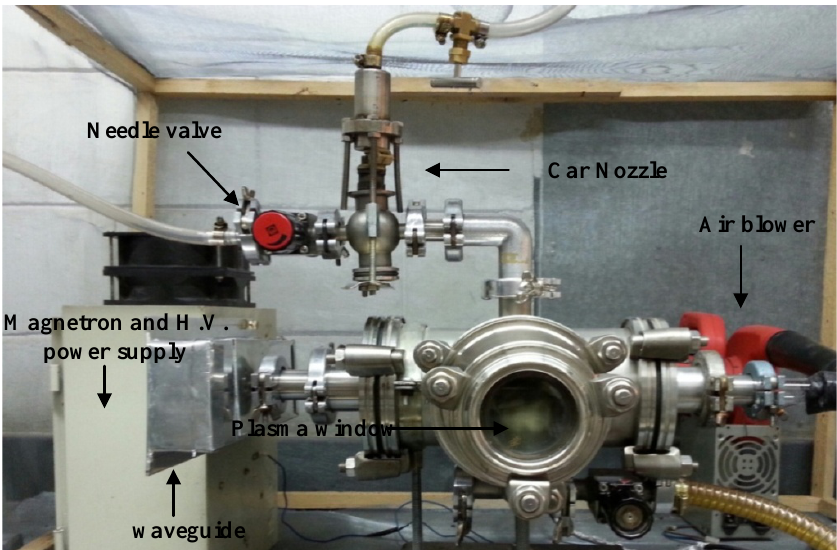
Fig.2 : Photograph of microwave induced plasma for nanocomposite thin films